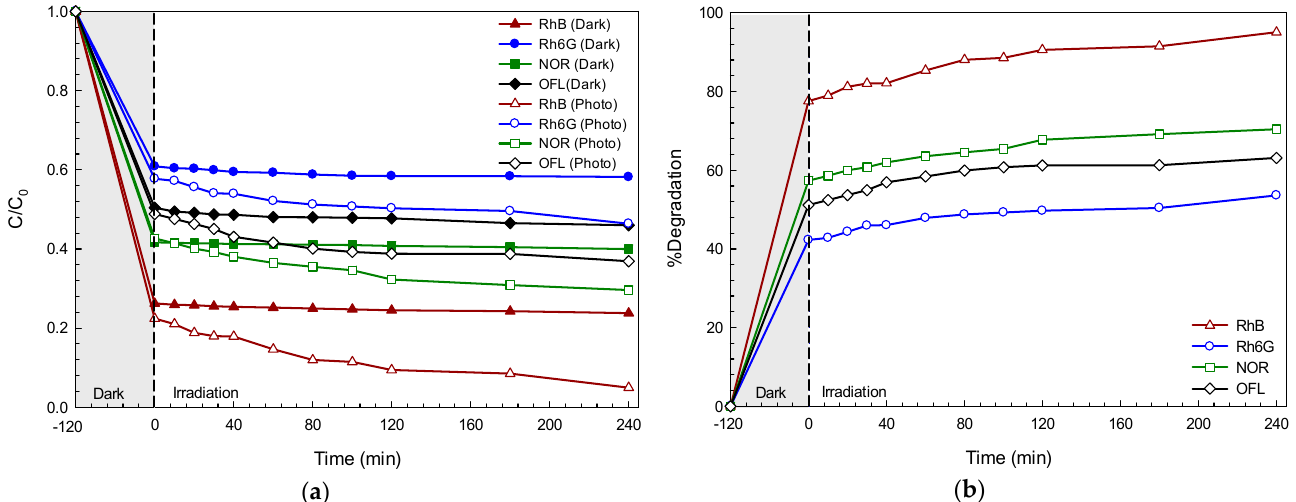
Figure 3. Plots of pollutant concentration (C/C 0 ) vs. time in the presence of BiOI photocatalyst under visible light irradiation ( a ) and the corresponding photocatalytic efficiency ( b ).